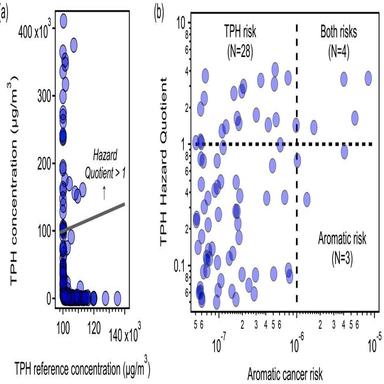
Evaluating risk from total petroleum hydrocarbon in each soil gas sample (circles), defined as the total mass in all hydrocarbon groups between C7 and C18. (a) Comparison of observed TPH concentrations to weighted reference concentrations calculated following (Brewer et al., 2013). Line represents a ratio of 1:1. (b) Comparison TPH Hazard Quotient (i.e., observed concentration/reference concentration) to summed cancer risk from benzene, ethylbenzene, and naphthalene. Dashed lines represent screening levels,